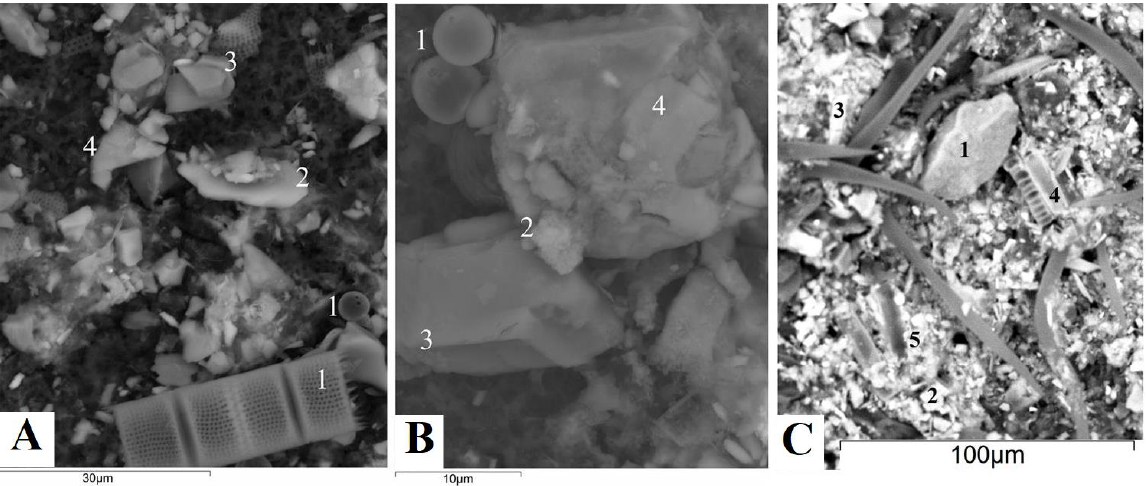
Figure 5. Micrographs made using SEM of samples of river suspended matter on filters taken in the Shuya ( A ), Vodla (B) and Sheltozerka ( C ) rivers: ( A ) 1—shells and biodetrite of diatoms,